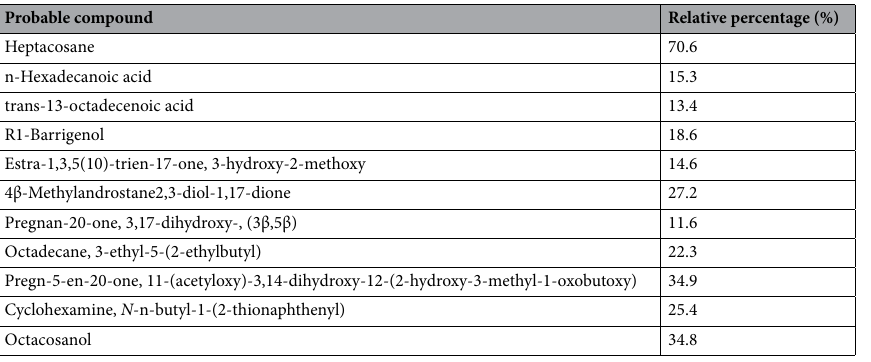
Table 1. GC–MS analysis of the Egyptian propolis